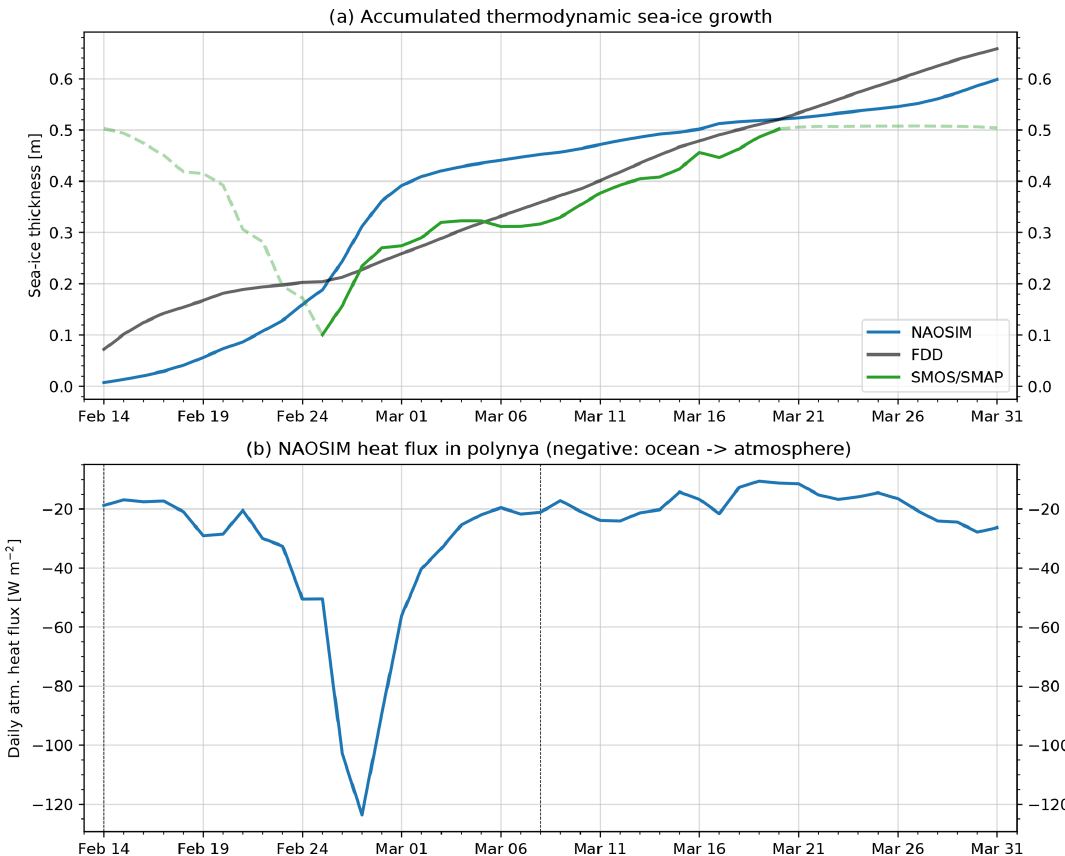
Figure 10. (a) Accumulated thermodynamic sea-ice growth after 14 February modelled by NAOSIM and estimated using the freezing degree day parameterisation. The SMOS/SMAP passive microwave sea-ice thickness product of the University of Bremen is shown for comparison. Days before the refreezing started are marked by the faint dashed line. The same holds for the days after the algorithm reached its maximally retrievable sea-ice thickness. (b) Spatially averaged atmospheric heat flux, defined negative upward (blue line) during the polynya event (vertical dashed lines).